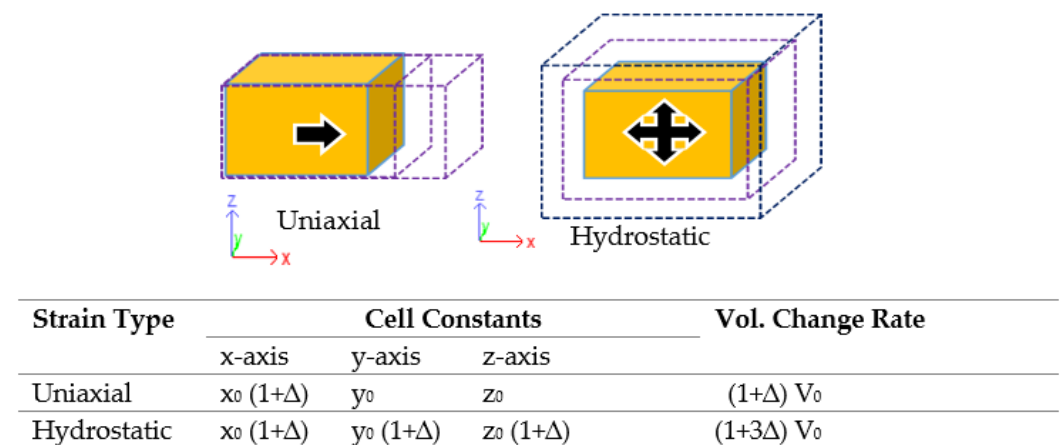
Figure 1. Description of uniaxial and hydrostatic strain applications. The integrated table shows the variations in cell constants and volumes of free strained values (x 0 , y 0 , z 0 , V 0 ) with a ∆ of strain for each strain type. For each deformed structure, the uniaxial strain was applied along the [100] direction of the simulation cell. The structure was deformed in the x-direction at a deformation rate of 0.002 ps-1 up to the target strain under the NVT ensemble. The lateral borders are fixed in such a way that the lengths of the cells along the y-and z-direction remain unchanged for the side borders. Under hydrostatic conditions, the strains are applied to each side of the structures along the [100], [010], and [001] directions with the same amount of strain for each direction. Recoil MD simulations were performed under the NVE ensemble, and for every sin- gle collision event, the simulations ran for 5 ps. The adaptive time step for the integration of Newton’s equations of motion was used. To evaluate the defect formation, we used the VORONOI package [29], as implemented in the LAMMPS code. All collision events were activated by depositing energy onto a specifically centered atom picked up from each strained structure, where the atom is known as PKA. When introduced, the deposited energy of the collision event was converted to correspond- ing PKA velocity components ( V x, V y, and V z). Initially, the PKA deposition energy of the initiated cascade event started at 5 eV and then increased incrementally by 1 eV until de- fects were formed. Once a defect was detected, this energy was considered as the mini- mum strained E d,i , i.e., 𝐸 (cid:3031),(cid:3036)(cid:3046)(cid:3047)(cid:3045)(cid:3028)(cid:3036)(cid:3041)(cid:3032)(cid:3031) . A systematic averaging of four 𝐸 (cid:3031),(cid:3036)(cid:3046)(cid:3047)(cid:3045)(cid:3028)(cid:3036)(cid:3041)(cid:3032)(cid:3031) of different simulation timings (0, 50, 100, and 150 fs) was applied. This averaging was conducted to overcome the deviation of the 𝐸 (cid:3031),(cid:3036)(cid:3046)(cid:3047)(cid:3045)(cid:3028)(cid:3036)(cid:3041)(cid:3032)(cid:3031) calculation that would be raised from the thermal vibration effect at 30 K [30]. For the evaluation of the directional effect, the ( E d,avg ) of the 210 irreducible crystal directions (ICD) were evaluated for free-strained structure. The method for ICD directions preparation was reported previously [25,30]; however, the 𝐸 (cid:3031),(cid:3028)(cid:3049)(cid:3034) (cid:3046)(cid:3047)(cid:3045)(cid:3028)(cid:3036)(cid:3041)(cid:3032)(cid:3031) evaluation is conducted over 300 quasi-uniform directions. 2.2. The Collision Cascades Evaluation under Strain Similar calculation settings of 30 K and 0 Pa were applied, and the systems with 30 × 30 × 30, 45 × 45 × 45, 55 × 55 × 55, and 60 × 60 × 60 supercells, containing 54,000, 182,250, 332,750, and 432,000 α -Fe atoms, respectively, were constructed. The considered systems were confirmed to be sufficient to distribute the temperature of the system after the start of the collision event by 1, 3, 6, and 10 keV over <111>, <110>, <100>, and <321> collision directions and the average temperature was less than 200 K after the end of the simulation, while the displacement cascade was not in contact with the cell boundaries. Subsequently, the hydrostatic strain ranging between − 1.4% and +1.6%, with an increasing step of 0.6%, resulted in six different structures. For every single collision event, the displacement evo- lution runs up to 20 ps in the canonical NVT ensemble, which was associated with the need